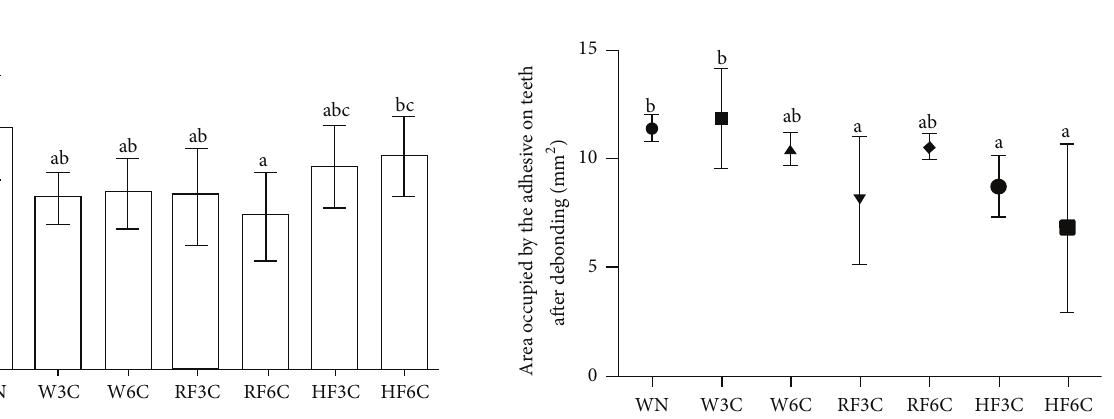
Figure 3: Bond strength values of groups submitted to the shear bond strength test. Different letters indicate statistical difference (one-way ANOVA and post-hoc Tukey tests, 𝑃 < 0.05 ).